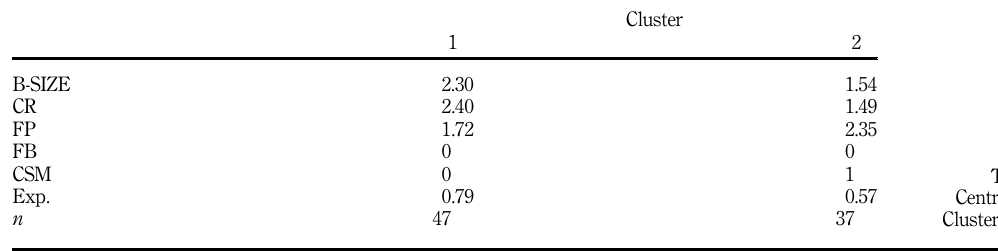
Table III. Centroid of